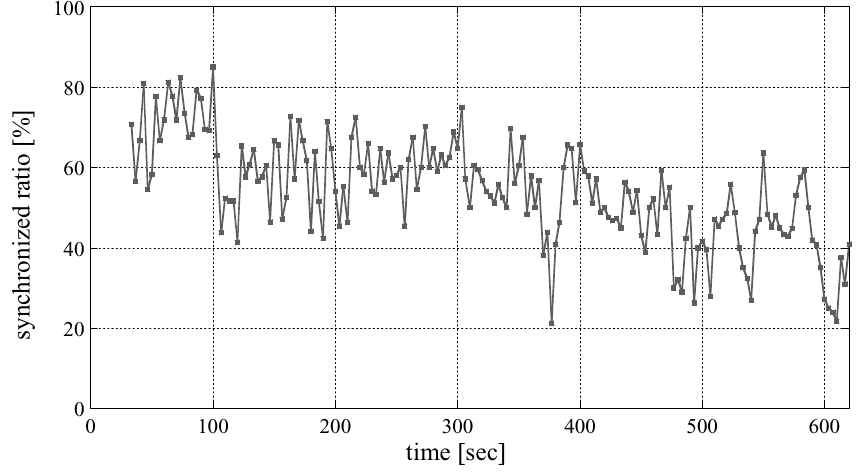
Fig. 12. Time-history of the synchronized ratio of pedestrians during the large lateral vibration in T-Park